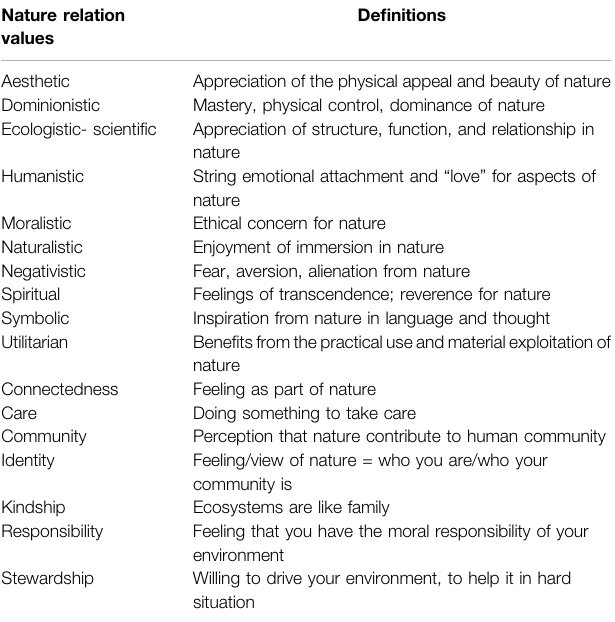
TABLE2| De fi nitionofspeci fi cvalues(Kellert2008;DosSantosandGould2018). Nature relation